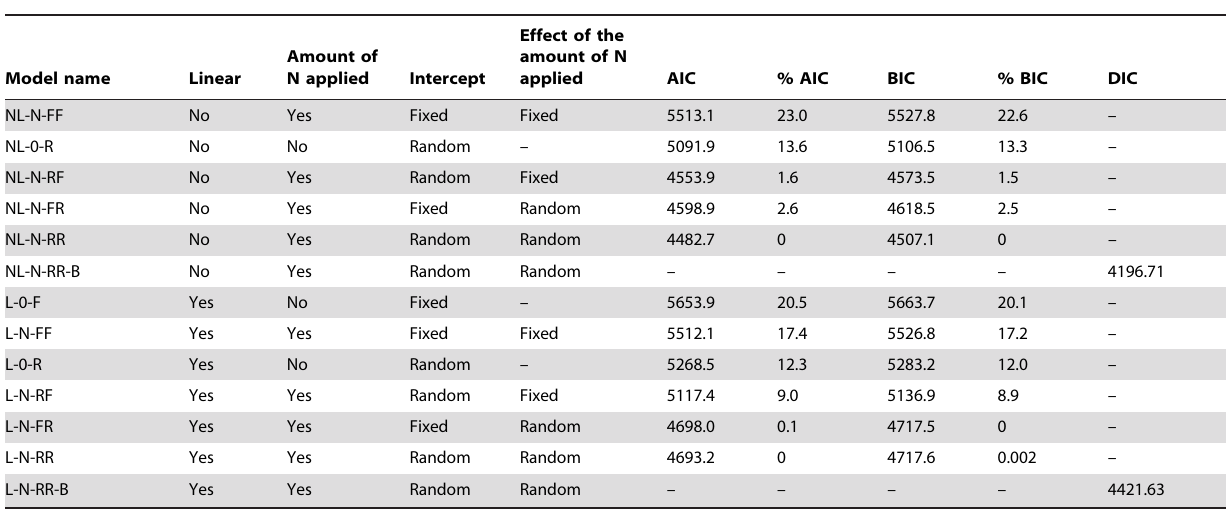
Table 2. Characteristics of the 13 statistical models for N 2 O